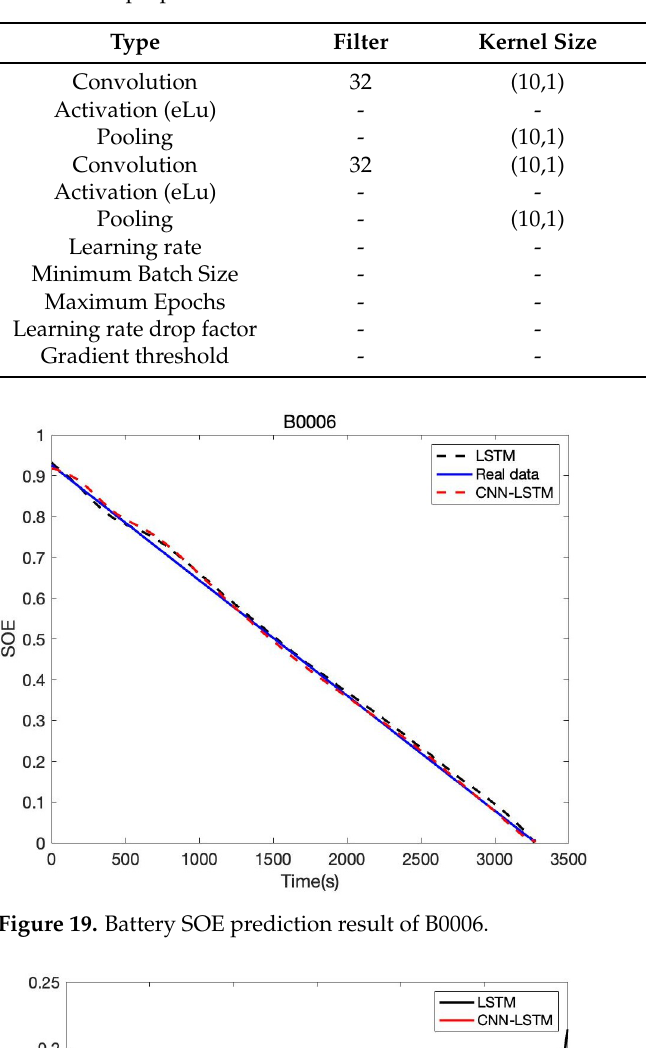
Table 5. The proposed CNN-LSTM architecture.